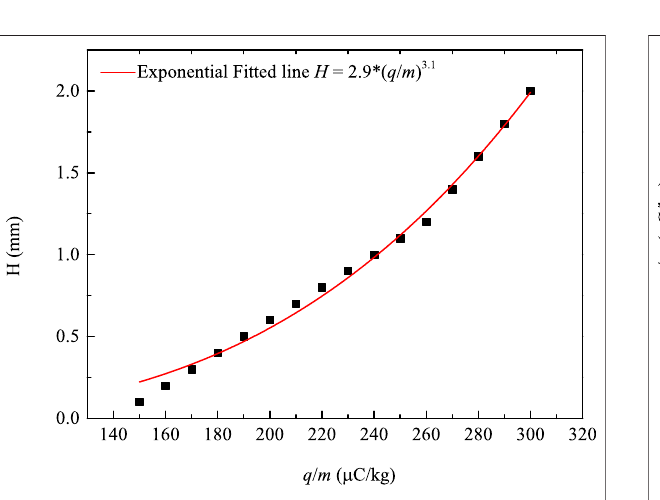
FIGURE 10 | Each size of a particle corresponds to a threshold charge- to-mass